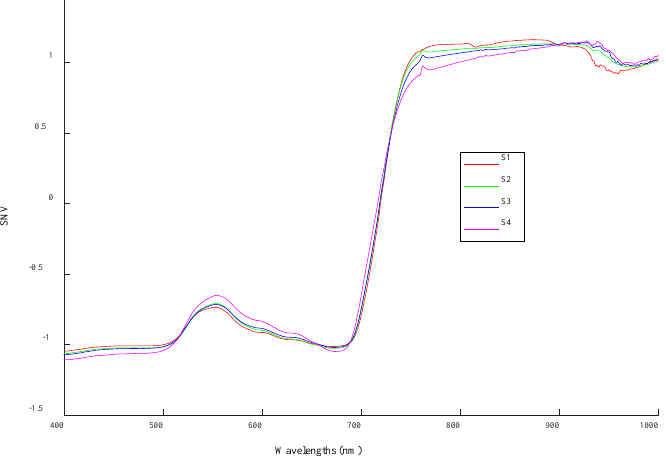
Figure 3. Average canopy spectral curve per potato growth stage after standard normal variate